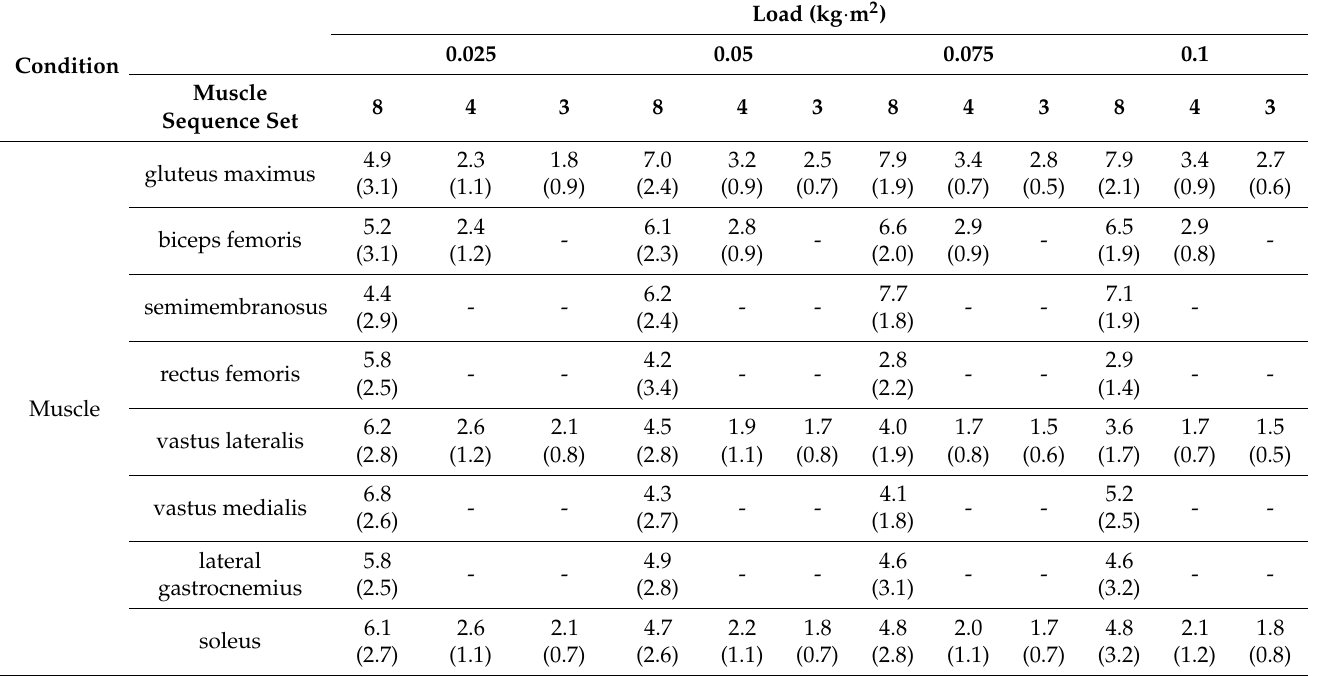
Table 3. Time-of-peak-activation ranks for 8, 4, and 3 muscle sequence sets.